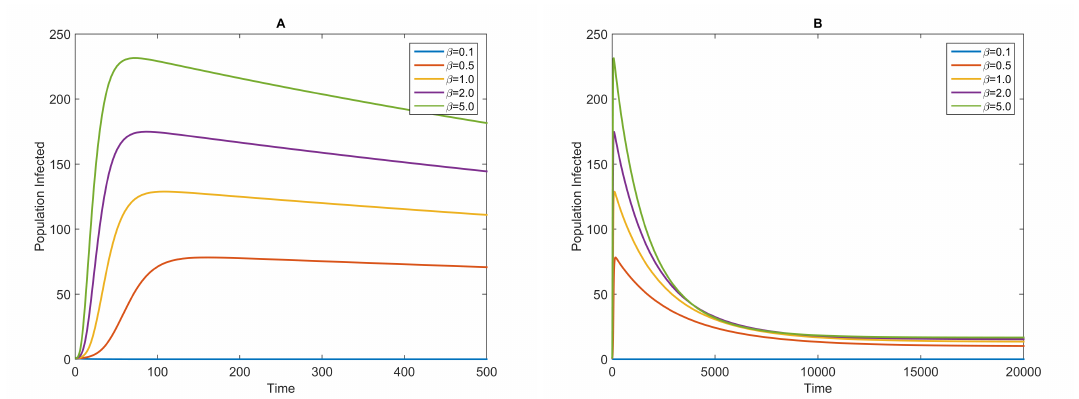
Figure 3. Infectious curves for different values of β and fixed k for the NBD model (Equation (4)). The values of β are shown in the legend. The other parameters are as follows: k = 10 − 4 , 1 1 = 5 days and 1 = 70 years. The initial conditions are S ( 0 ) = 99,999, E ( 0 ) = 0, I ( 0 ) = 1 and γ µ R ( 0 ) = 0. ( A ) The infectious curves around the peak; ( B ) The long trend of the infectious curves of the NBD model with the same